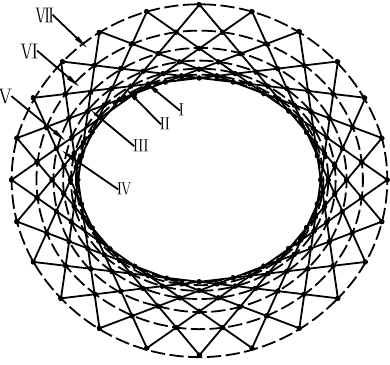
Figure 7. The number of virtual rings. Table 2. Cable clamp deletion schemes.